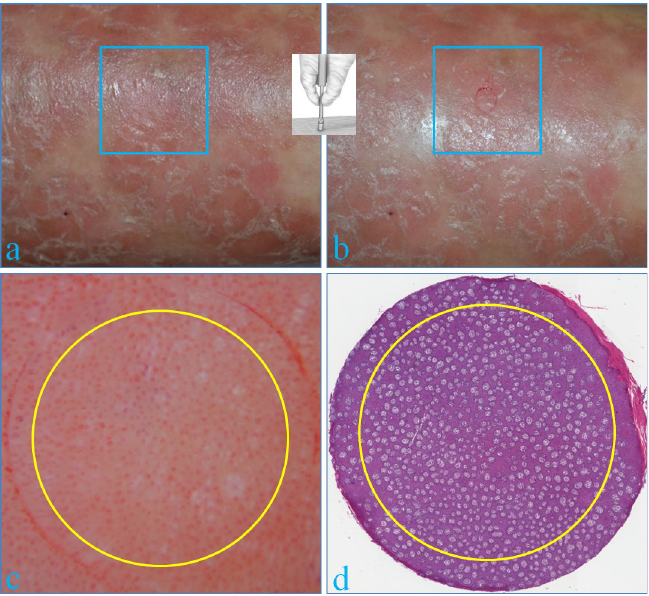
Fig 1. Stable psoriatic plaque of the lower leg before (a) and after engraving a target area by gently rotating a 5-mm biopsy punch device (b). Dermoscopy (x10) (c) and HHS (H&E stain: x100) (d) of the target area: the capillary density was evaluated in both cases in a centered 4-mm diameter area (yellow circle) by counting the number of red dots and of dermal papillae, respectively.